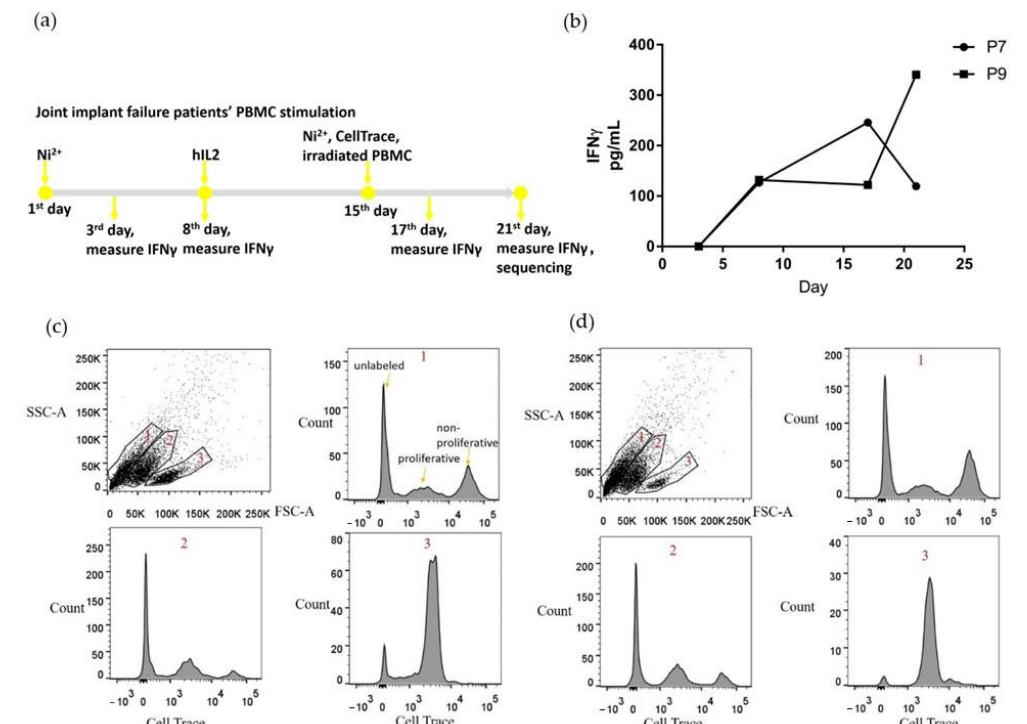
Figure 1. Ni 2+ treated PBMCs include proliferating cells after three weeks in vitro culture. ( a ) shows the stimulation protocol for PBMCs derived from joint implant failure patients; ( b ) levels of secreted IFNγ in the culture media; ( c ) and ( d ) flow cytometry results of the harvested PBMCs at the last day of stimulation for P7 and P9, respectively. Based on the size and scattering, cells were separated into three populations. We examined the CellTrace dye fluorescence for each of the three populations separately. The “unlabeled”, “proliferative”, and “non-proliferative” peaks are indicated in ( c ) 1 population, and similar in the other panels. The proliferative cells in populations 2 and 3 were collected for single cell sequencing.